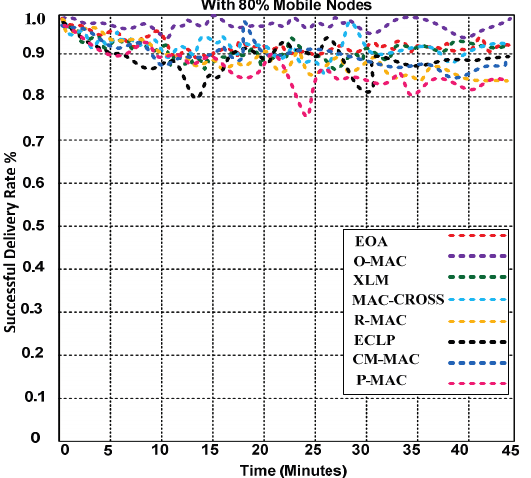
Figure 10. Successful packet delivery rates of O-MAC and other competing hybrid MAC protocols with 80% mobile nodes.